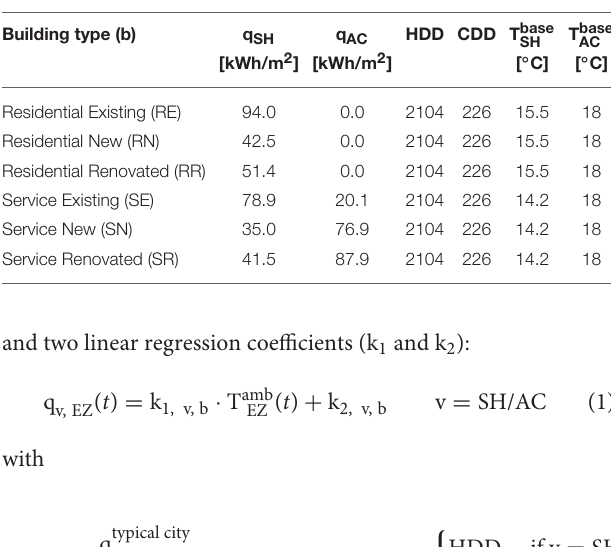
TABLE 2 | Heating signature parameters for typical urban center. TABLE 3 | Building parameters for a typical urban